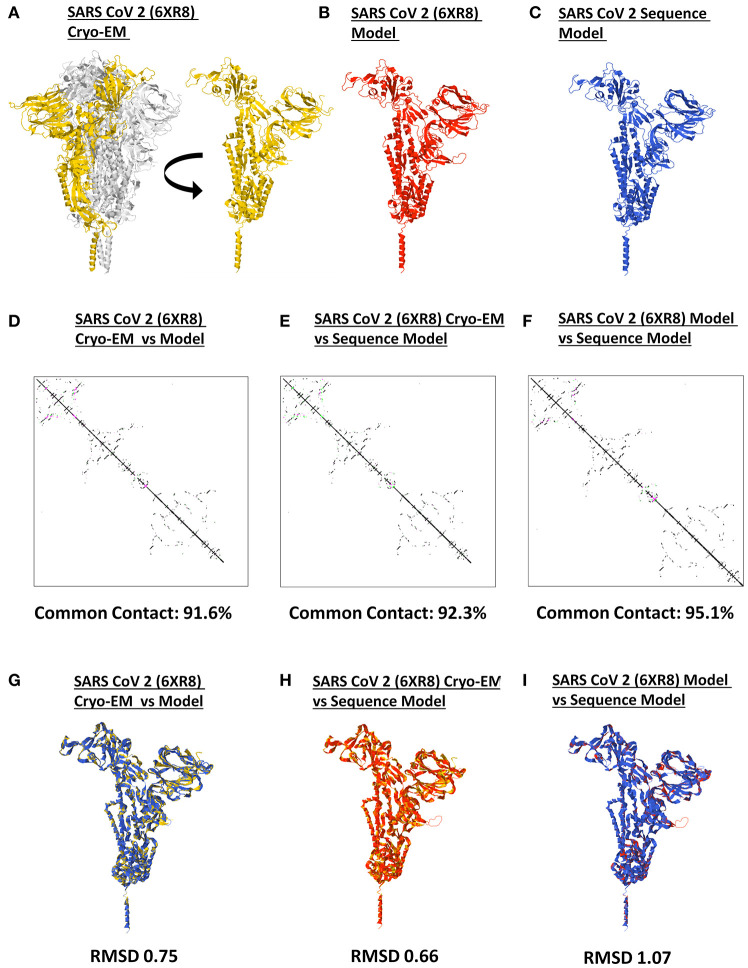
Model quality assessment of a generated monomeric SARS-CoV-2 spike protein. Representative SARS-CoV-2 (A) 6XR8 cryo-EM, (B) 6XR8 model, and (C) sequence model of monomeric spike proteins are indicated. Contact maps of (D) 6XR8 cryo-EM and model, (E) 6XR8 cryo-EM and sequence model, and (F) 6XR8 model and sequence models are shown. The common contact of the protein structures being compared is labeled below. Superimposition between (G) 6XR8 cryo-EM and model, (H) 6XR8 cryo-EM and sequence model, and (I) 6XR8 model and sequence models are presented. RMSD scores of the superimposed protein structures are indicated below. SARS CoV 2 6XR8 cryo-EM (yellow), 6XR8 model (red), and sequence model (royal blue) are indicated.